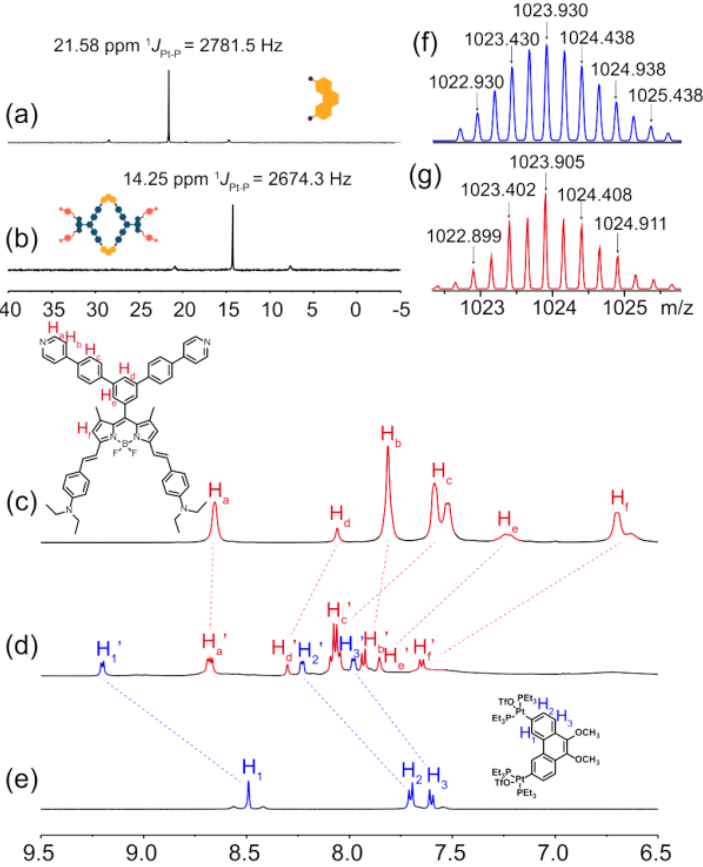
Figure 1. 31 P{ 1 H} NMR spectra of ( a ) 2 and ( b ) M (202 MHz, CD 3 OD, 298 K). Partial 1 H NMR spectra of ( c ) ligand 1 , ( d ) metallacycle M , and ( e ) acceptor 2 (500 MHz, CD 2 Cl 2 , 298 K). ( f ) Calculated (blue) and ( g ) experimental (red) ESI-TOF-MS peaks of [ M − 4OTf] 4+